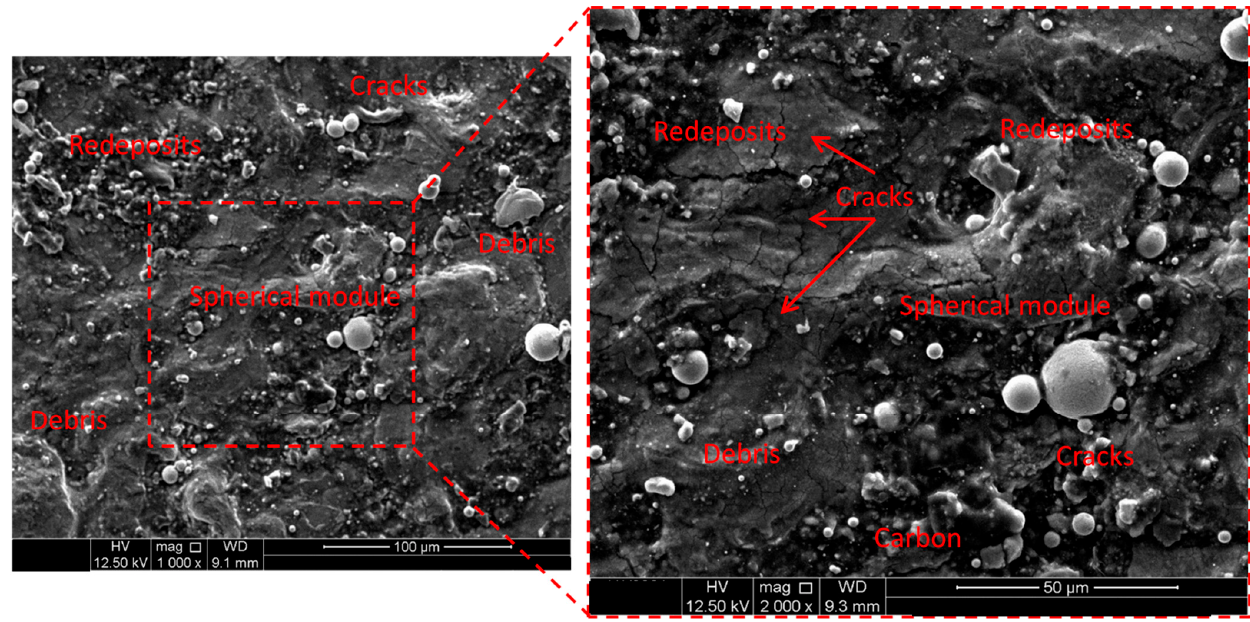
Figure 8. Surface morphology of kerosene-mixed S-20 dielectric at 37.5 g/L, pulse ON:OFF time of 50:100 µ Sec, and using the aluminum